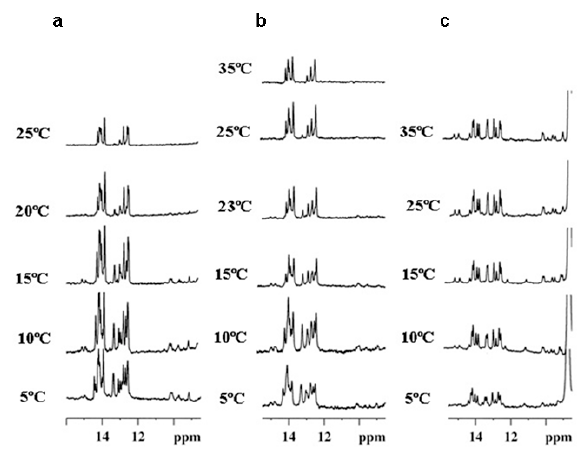
Figure 4. ( a ) NMR spectra at different temperatures of the triplexes formed by the addition TFO RNA 1 to the hairpin 1 without cosolute; ( b ) in 20% EtOH; ( c ) in 20% of DMSO. Buffer 10 mM phosphate buffer, 100 mM NaCl pH 6.0.